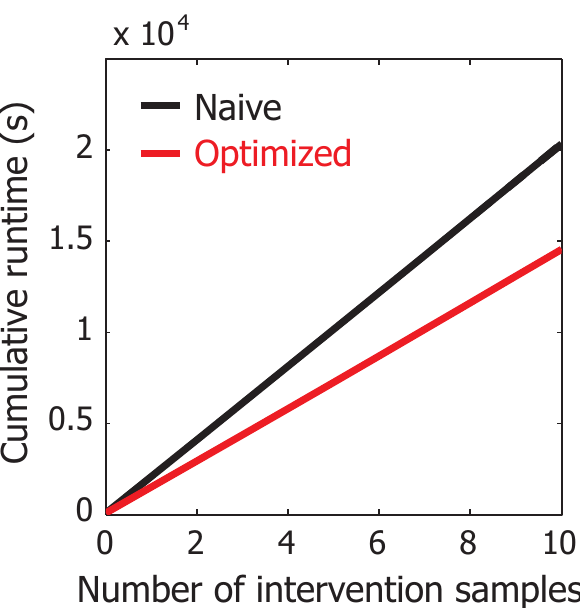
Fig 6. Runtime improvement of our method on simulated data. The results are summarized over three trials (error bands are not visible due to low variance). Our optimization technique specific to GBNs leads to significant improvement in